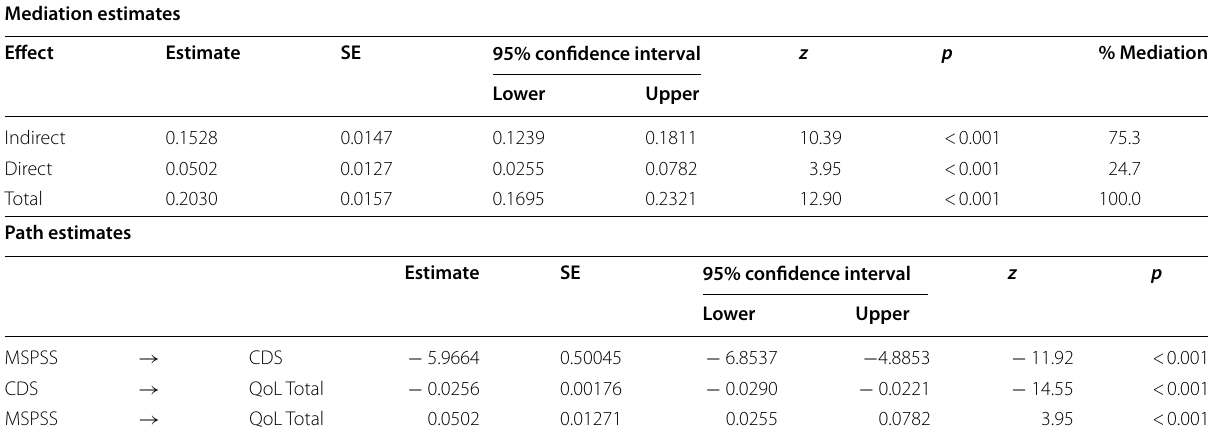
Table 3 Mediation with perceived social support as a predictor, quality of life as a dependent variable and depression as a mediator with unstandardized estimates Mediation